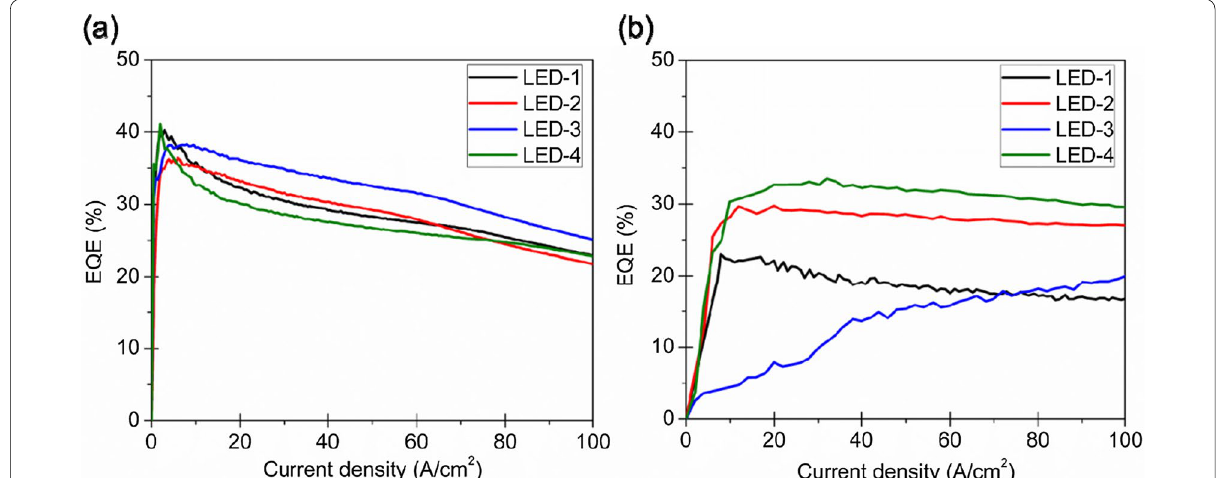
Fig. 5 Dependence of the EQE on current for a 100